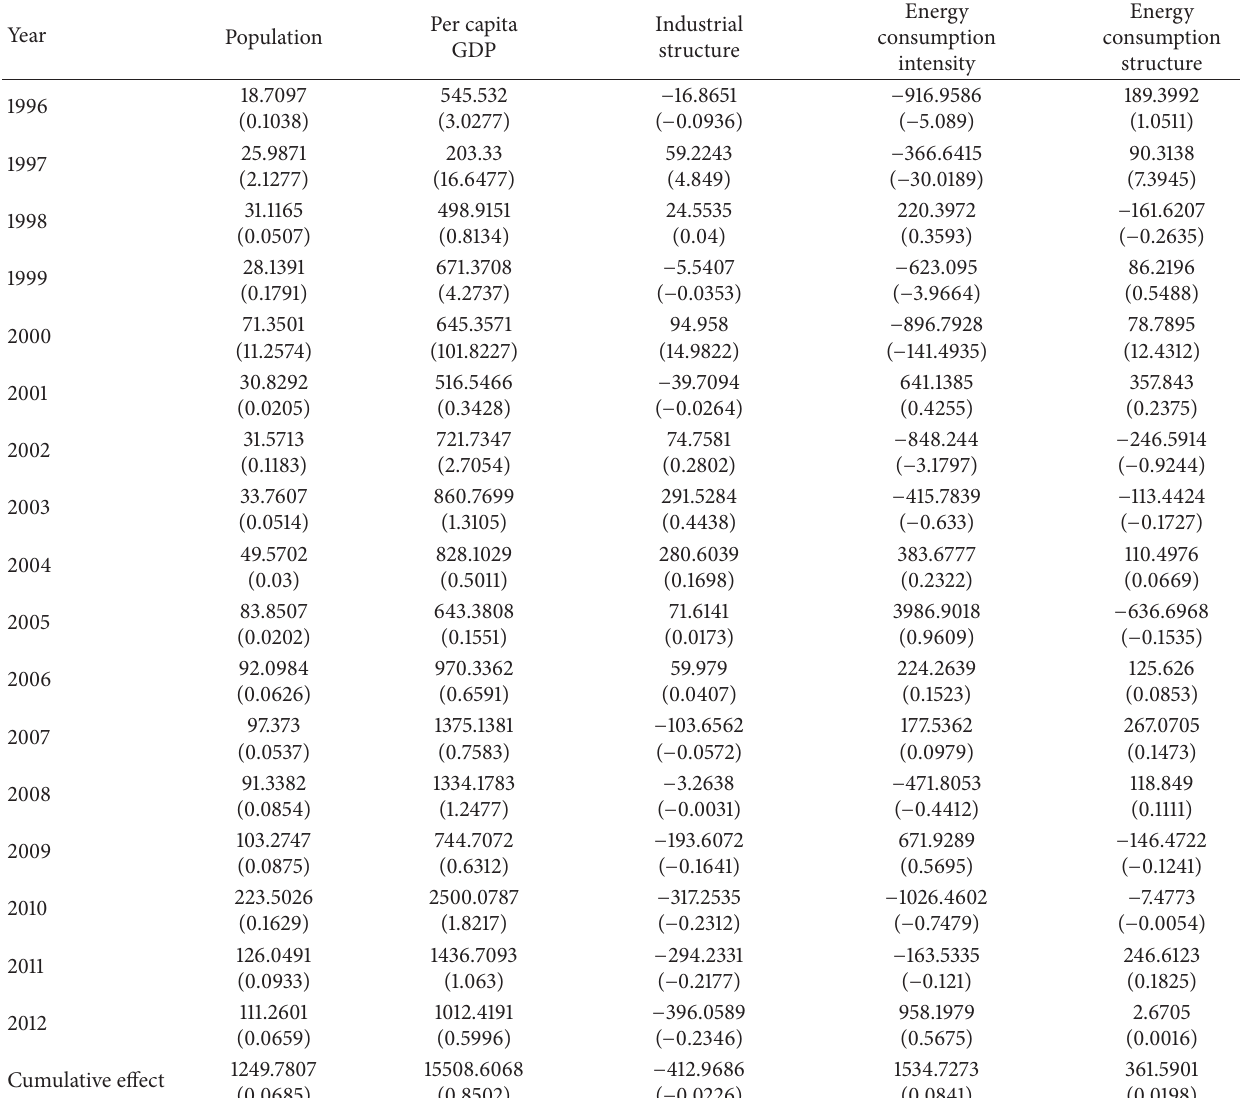
Table 4: Effects of different factors of carbon emissions from energy consumption of Shandong province from 1996 to 2012 by MRCI model.